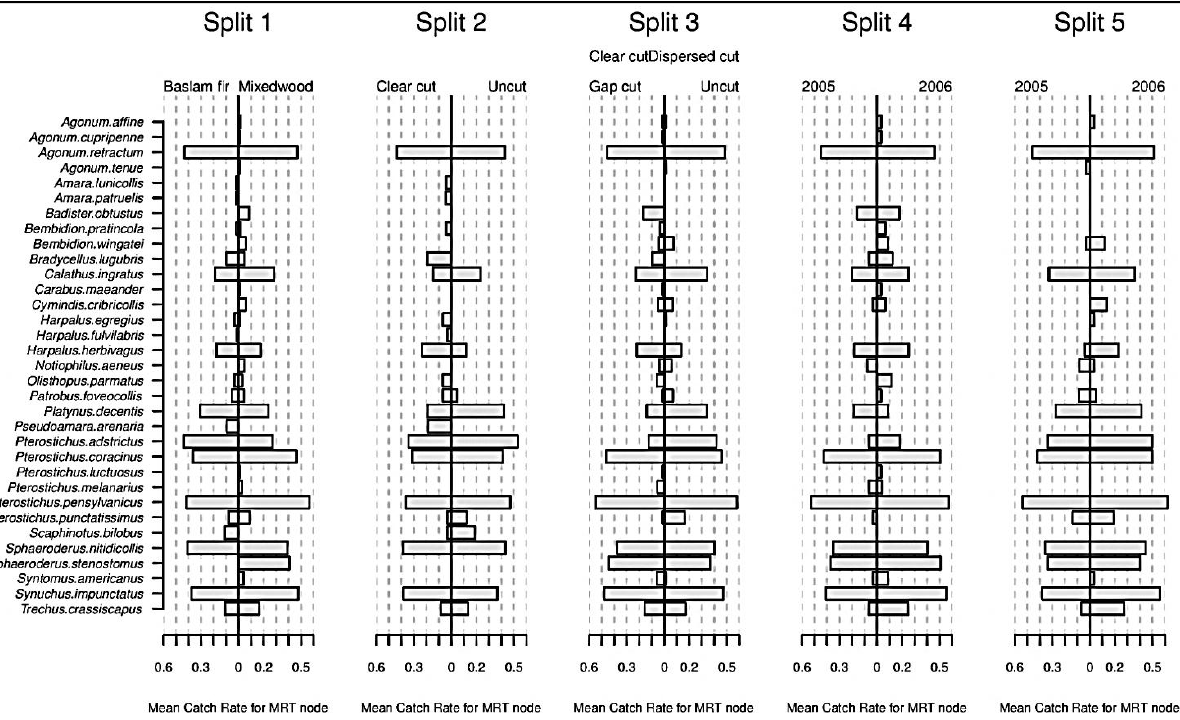
Figure 7. Species means around ssMRT nodes indicating relative contribution to individual regression tree splits. Left and right bars correspond to left and right splits of the